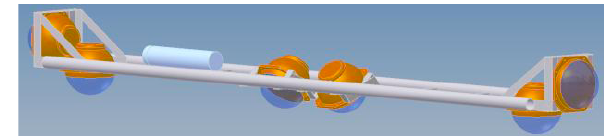
Fig. 8. The storey for the bar detection unit.